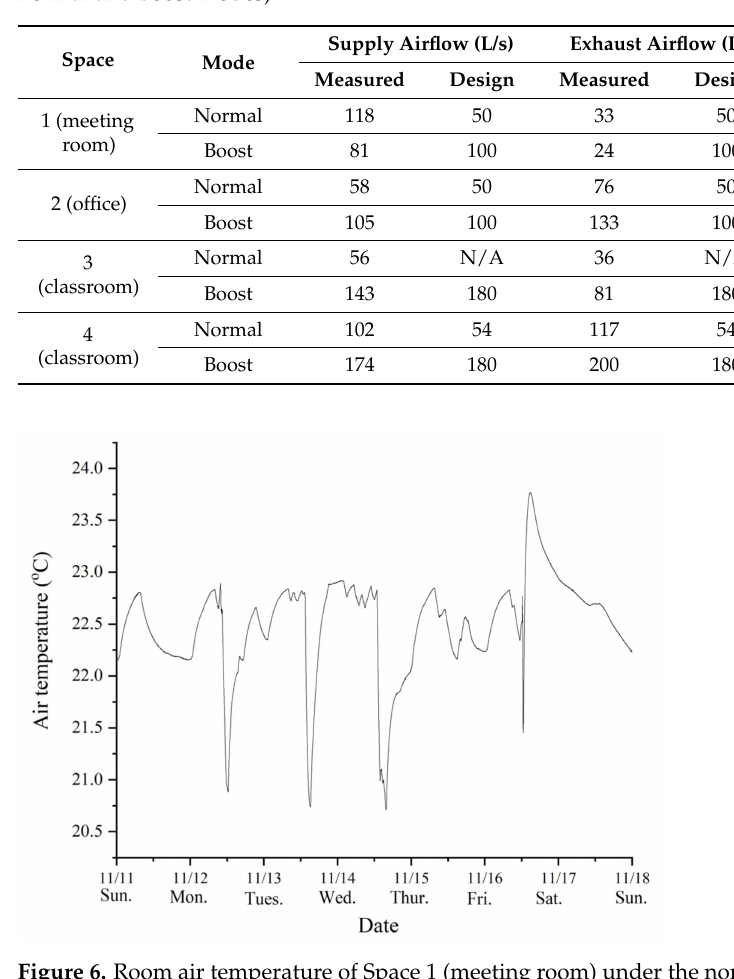
Table 7. Measured and designed airflows and control strategies for Type 1 spaces (all-air system with normal and boost modes).